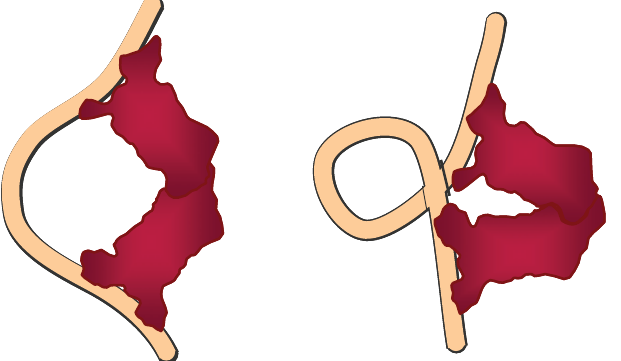
Figure 1. Two plausible alternative loop conformations of the lac repressor-DNA complex. The bidentate repressor, with the two dimers that form the functional tetramer shown in red, simultaneously binds DNA, colored orange, at two sites. The two structures represent two plausible trajectories of the DNA loop and two plausible conformations of the lac repressor (V-shaped and extended).